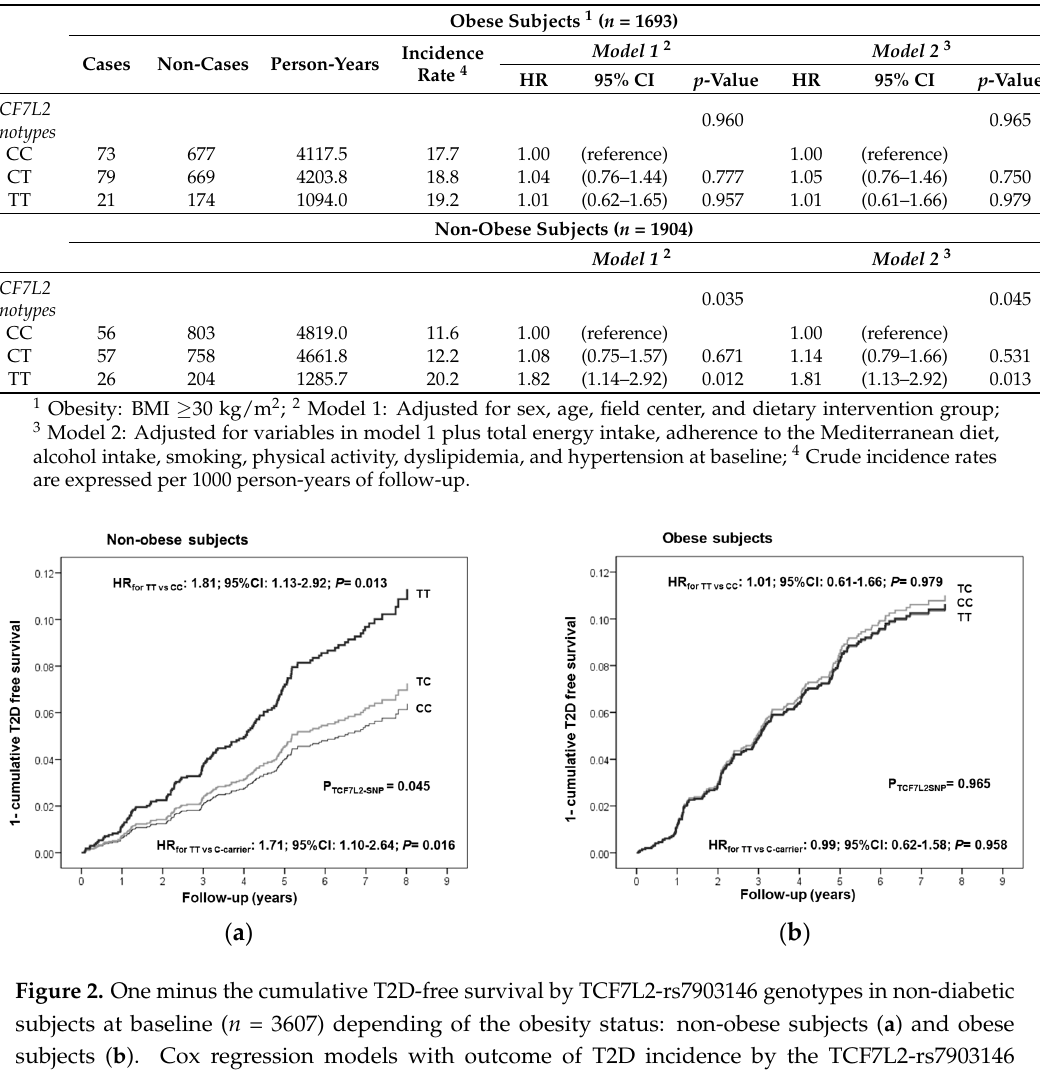
Table 4. Incidence and hazard ratios (HR) for T2D depending on the TCF7L2-rs7903146 polymorphism and stratified by obesity after 5.7 years of median follow-up.